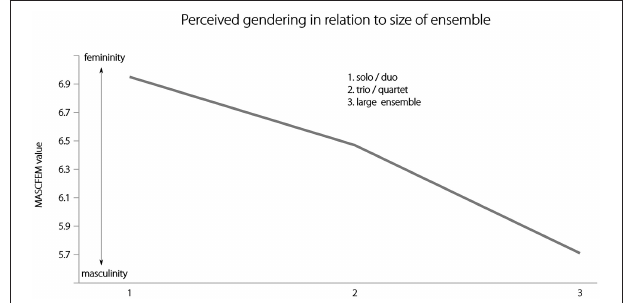
FIGURE 5 | Increase in perceived masculinity with increasing size of